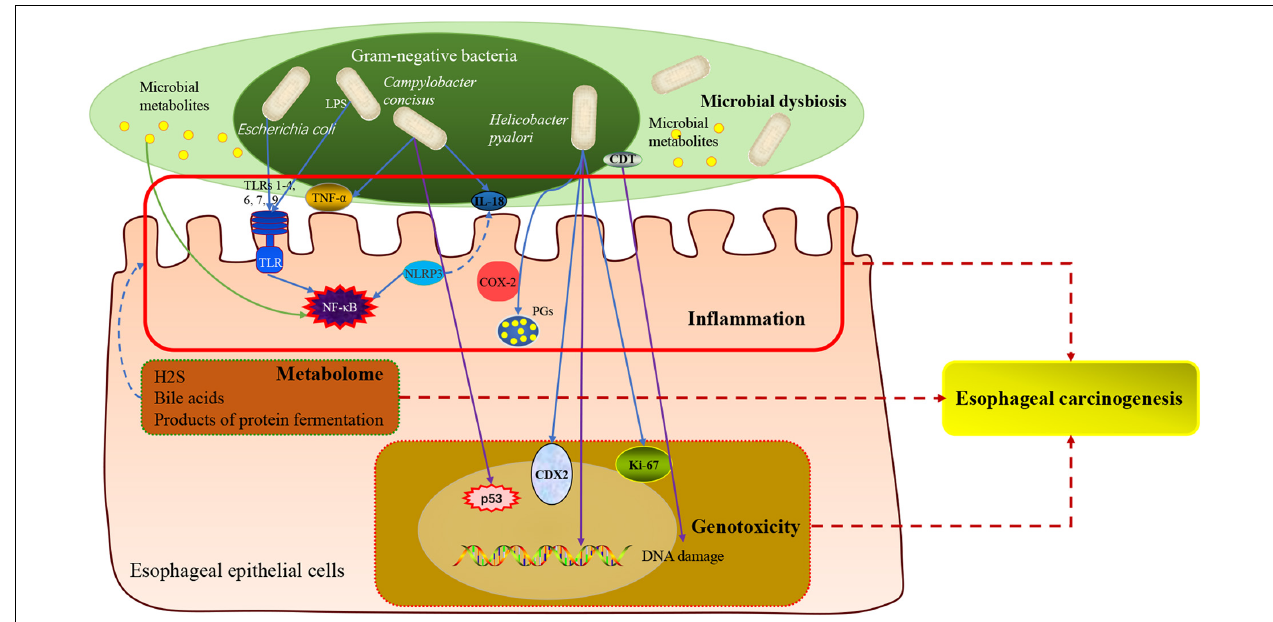
FIGURE 4 | The novel microbiota-related targets in screening, diagnosis, prognosis, and therapy for esophageal